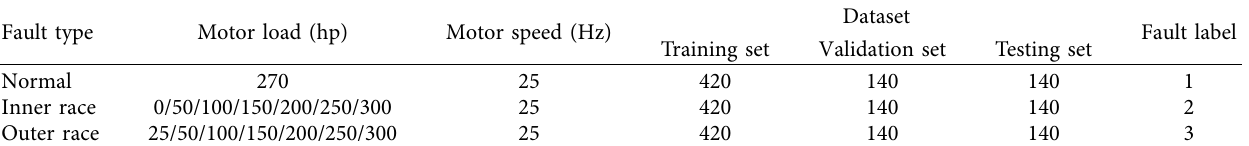
Table 2: Description of MFPT